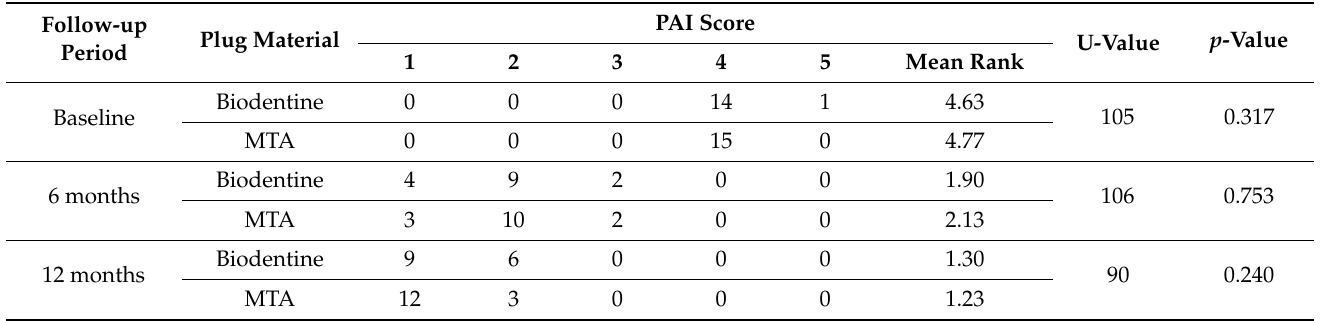
Table 2. Comparison of PAI scores between the two